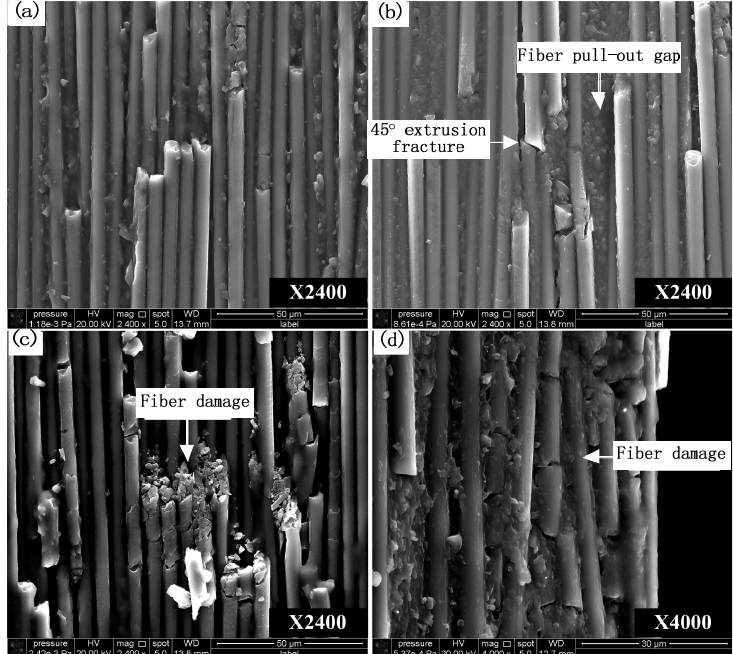
Figure 11. Fracture topography SEM photos of carbon fiber with 0° orientation angle. ( a – c ) 0° orientation angle with 2400X magnification; ( d ) 0° orientation angle with 4000X magnification.